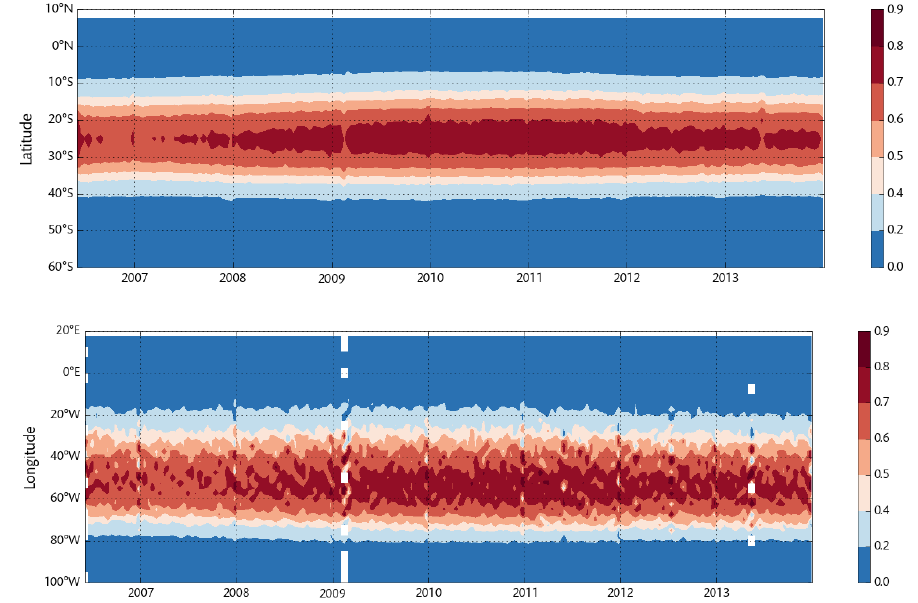
Figure 3. Evolution with time of the fraction of noisy profiles (333m horizontal resolution) as a function of latitude between 70 ◦ W and 30 ◦ W (top) and longitude between 40 ◦ S and 10 ◦ S (bottom). White boxes in the bottom figure are due to missing Fig. 3: Evolution with time of the fraction of noisy profiles as a function of (top) latitude between the West and East boundaries of the SAA (80°W to 10°W, red box in Fig. 1), and (bottom) longitude between the North and South boundaries of the SAA (10°S to 45°S). White boxes in the bottom figure are due to missing data. ! !